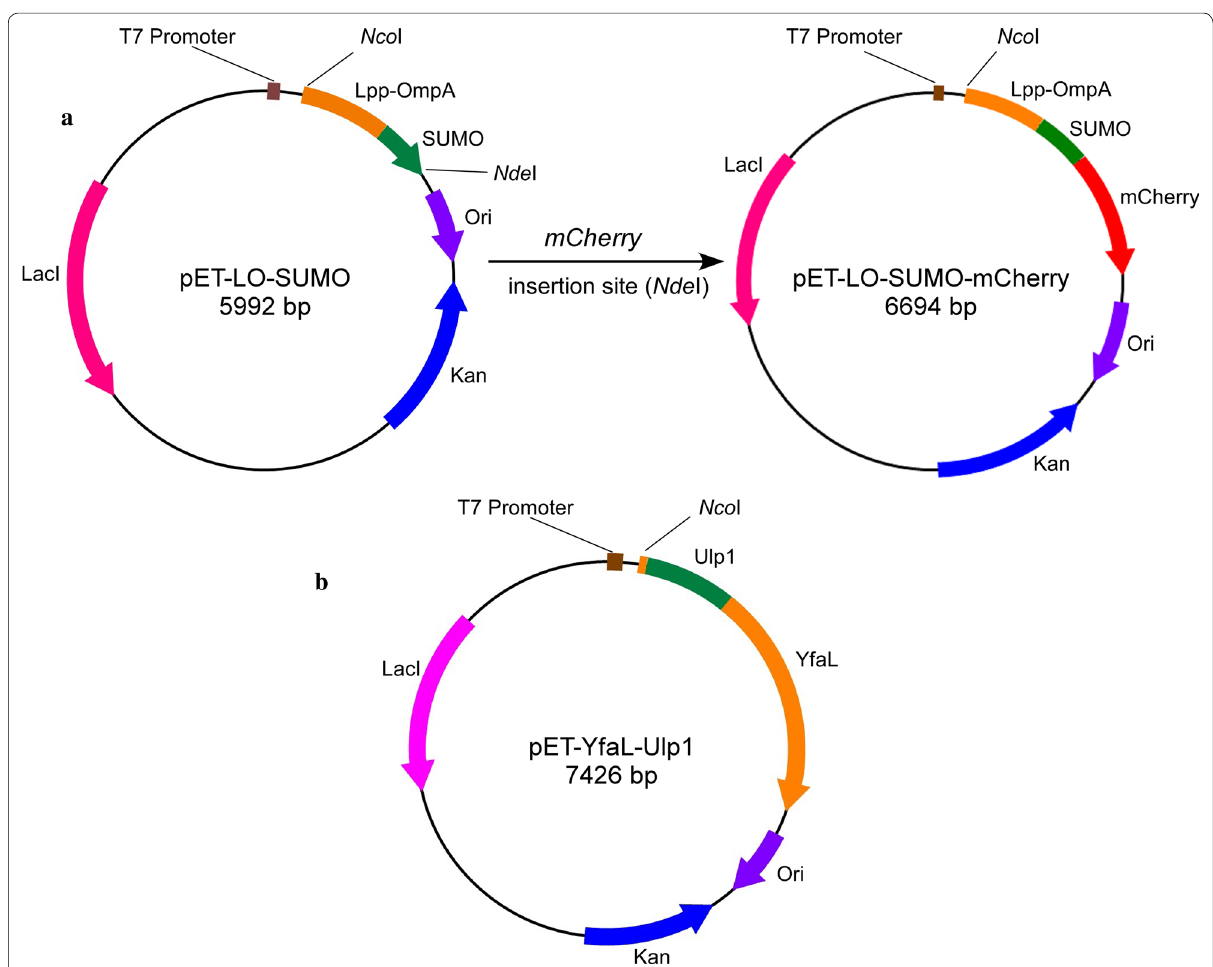
Fig. 2 Schematic illustration of the vectors constructed for the expression of surface‑displayed SUMO‑fused recombinant protein ( a ) and Ulp1 protease ( b ). The coding sequence of the target protein can be inserted into the universal expression vector ( a ) at the NdeI restriction